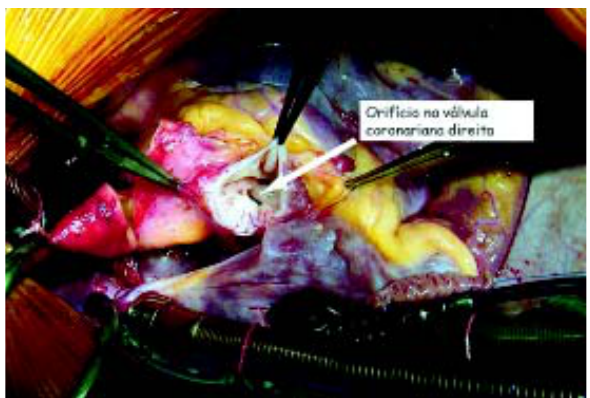
Fig. 2 – Orifício na válvula coronariana direita da valva aórtica visibilizado através da região aneurismática